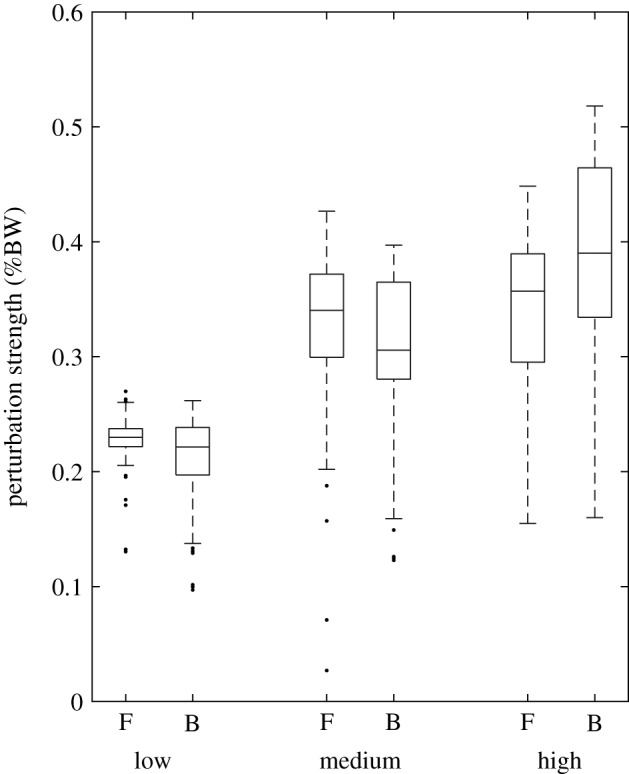
This figure shows typical peak perturbative force values (normalized by subject body weight) for the forwards (F) and backwards (B) perturbations applied at the low, medium and high force levels. These peak forces were averaged across subjects and Sit-to-Stand strategies to produce this plot. For each force level, the central mark indicates the median peak force. The bottom and top edges of the box indicate the the 25th and 75th percentiles, respectively. The whiskers extend to the most extreme forces not considered outliers, and the outliers are plotted individually.